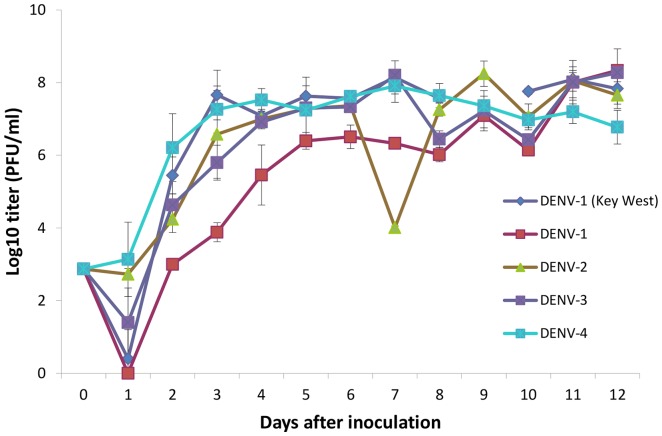
Dengue virus growth curves in Vero cells over a 12-1, PR DENV-2, PR DENV-3, PR DENV-4, and KW DENV-1.Standard deviation is calculated from replicate (N = 4) samples tested at each time point and each isolate showed significantly different growth rates (ANOVA, p<0.001).